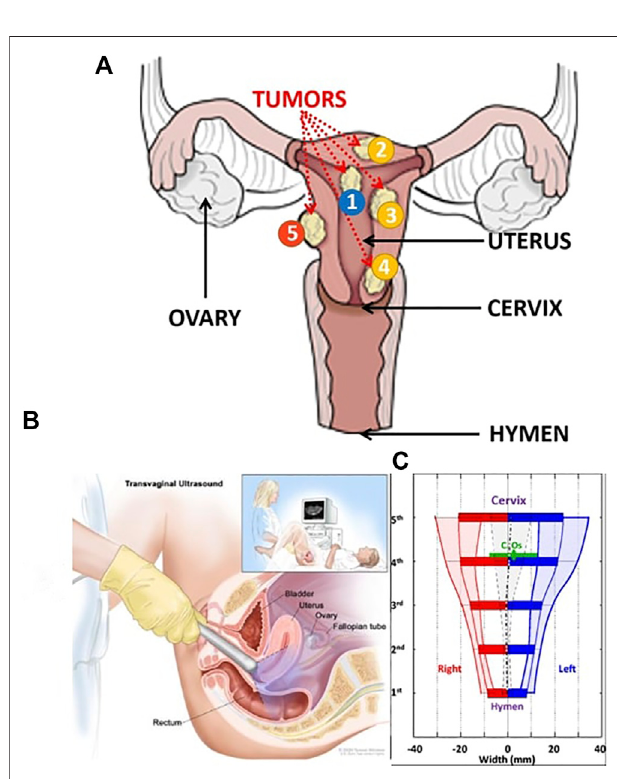
FIGURE 2 | (A) Uterus description with all types of tumors (Ochsner, 2021),modi fi ed. In blue (label 1) it is the submucosal tumors, in yellow (label 2,3,4) the intramural tumors and in orange (label 5) the subserosal tumors. (B) Clinical routine for transvaginal echography and (C) Vaginal measured description (Luo et al., 2016) modi fi